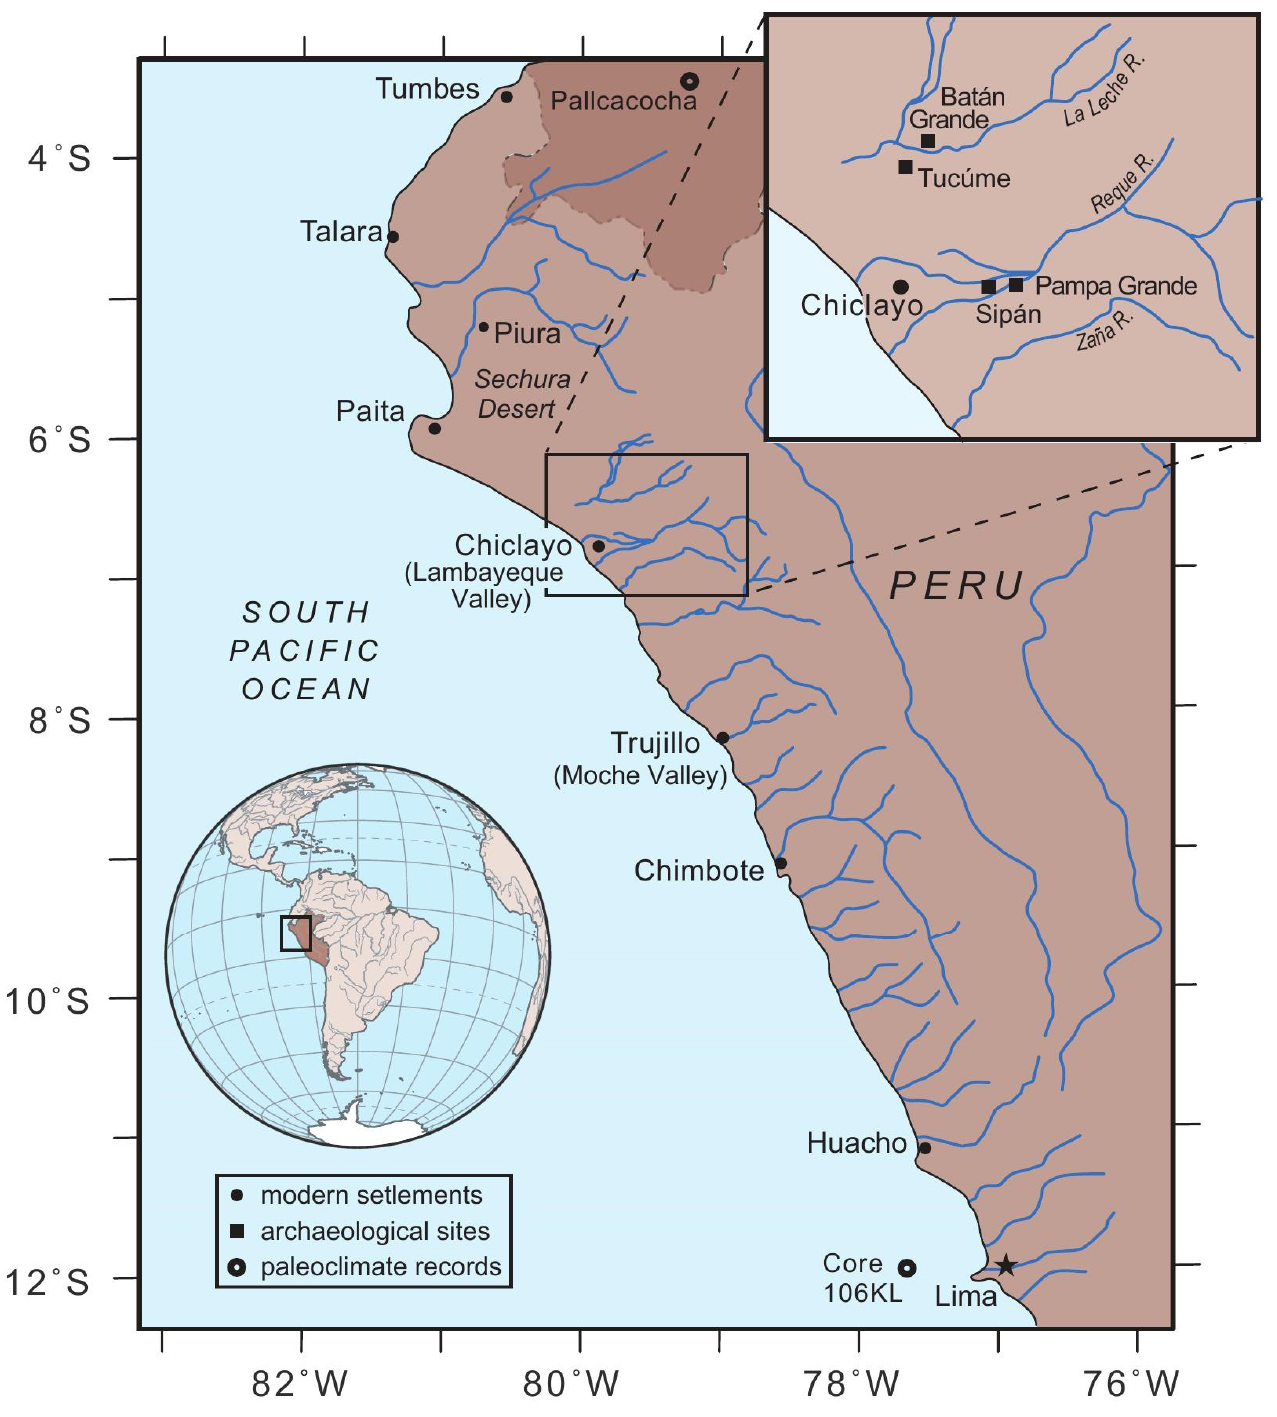
Figure 1. Map of Peru with inset showing the Lambayeque region and the sites mentioned in the text. (Map created by Kirk A. Maasch).